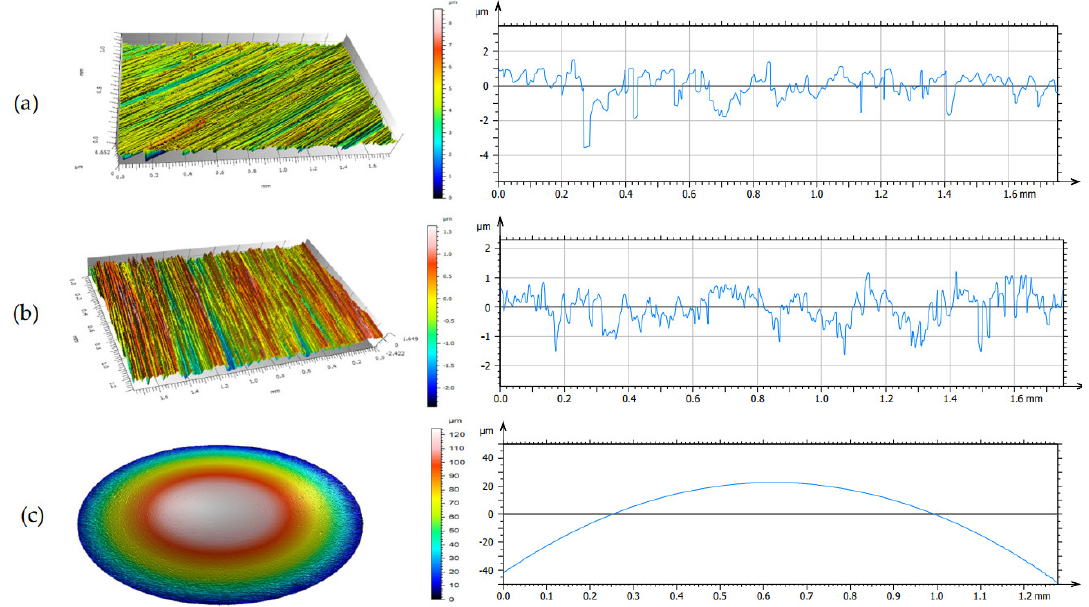
Figure 5. Surface textures before the tribological tests: isometric views and primary profiles of: ( a ) the a-C: H coated HS6-5-2C steel disc, ( b ) uncoated HS6-5-2C steel disc, ( c ) 100Cr6 steel ball.